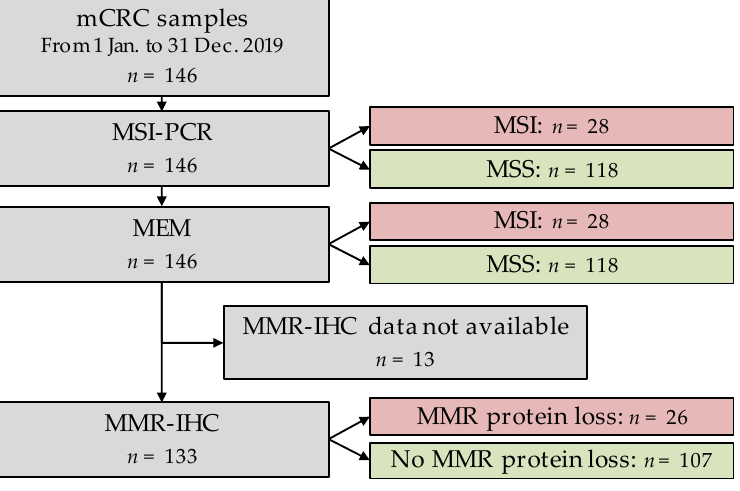
Figure 2. Study workflow.